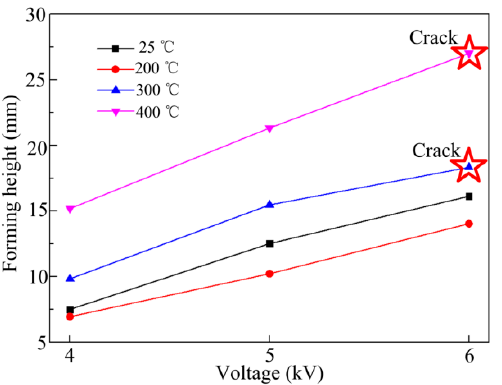
Figure 4. Change in sheet metal deformation with voltage at different forming temperatures.